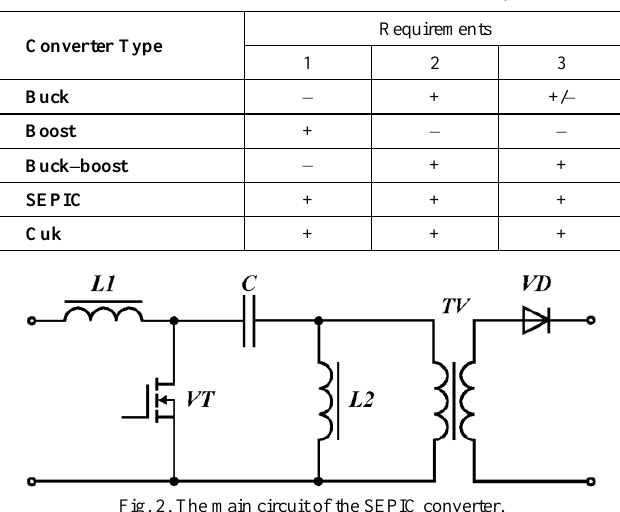
Fig. 2. The main circuit of the SEPIC